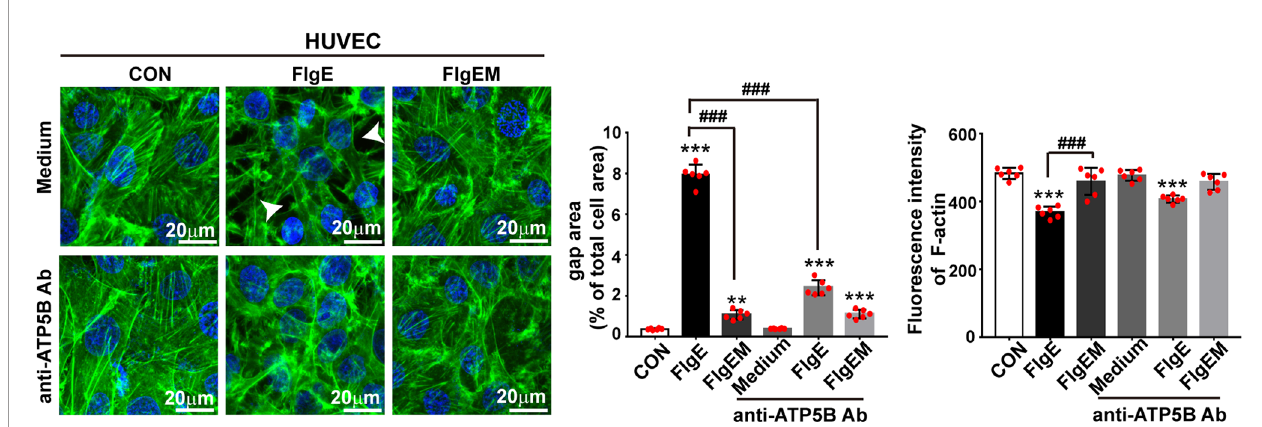
FIGURE 7 | EctoATP5B contributed to FlgE-induced reorganization of F-actin cytoskeleton. HUVECs and SVECs grown on glass coverslip were preincubated with anti-ATP5B antibodies (50 m g/ml) for 1 h and then stimulated with 20 m g/ml of FlgE or FlgEM for 24 h. F-actin fi laments of VECs were stained with FITC-phalloidin probes (50 m g/ml, green) and DAPI (blue), observed and captured with confocal microscopy, and analyzed with ImageJ. Scale bar, 20 m m. White arrow indicates gap formation among cells. The quanti fi cation of gap area and fl uorescence intensity of F-actin was performed using ImageJ software. ** p < 0.01, *** p < 0.001 vs . CON. ### p < 0.001 vs . FlgE by one-way ANOVA test. HUVECs, human umbilical vein endothelial cells; SVECs, SV40-transformed endothelial cells of mouse; VECs, vascular endothelial cells; FITC, fl uorescein